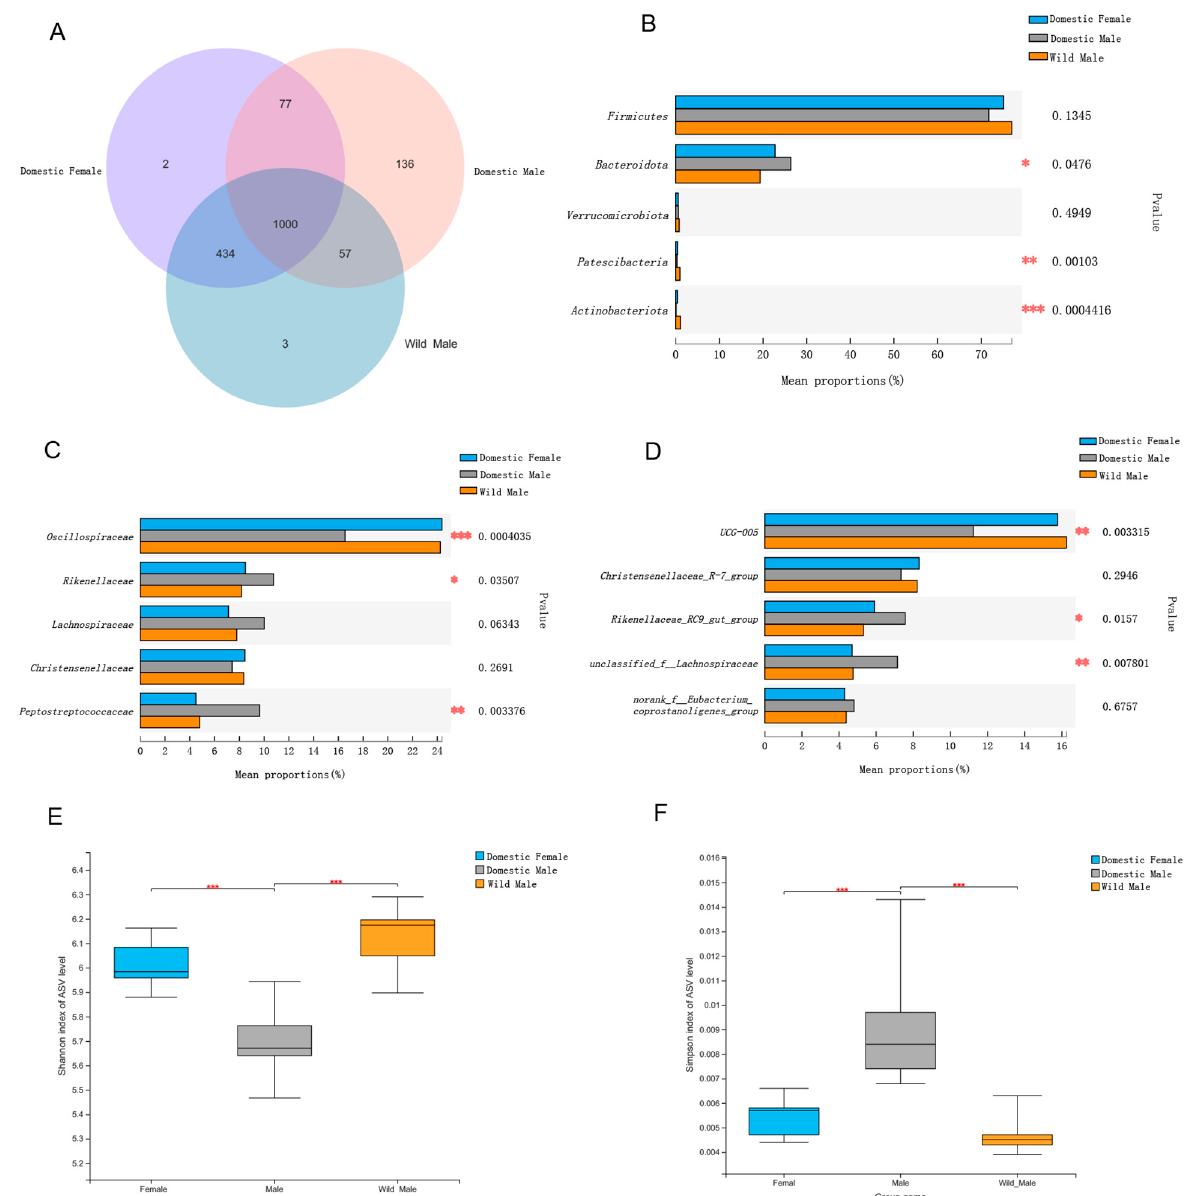
Figure 1 . Comparison of gut microbial diversity among Datong yak domestic males and females and wild male yaks. ( A ) Venn diagram at amplicon sequence variant (ASV) level; ( B ) Top five phyla; ( C ) Top five families; ( D ) Top five genera; α -diversity in the gut microbiota; ( E ) Shannon indices at the ASV level; ( F ) Simpson indices at the ASV level. Significant differences in the gut microbiota in the three groups are indicated by p values and asterisks (* if 0.01 < p < 0.05, ** if 0.001 < p < 0.01, and *** if p < 0.001).